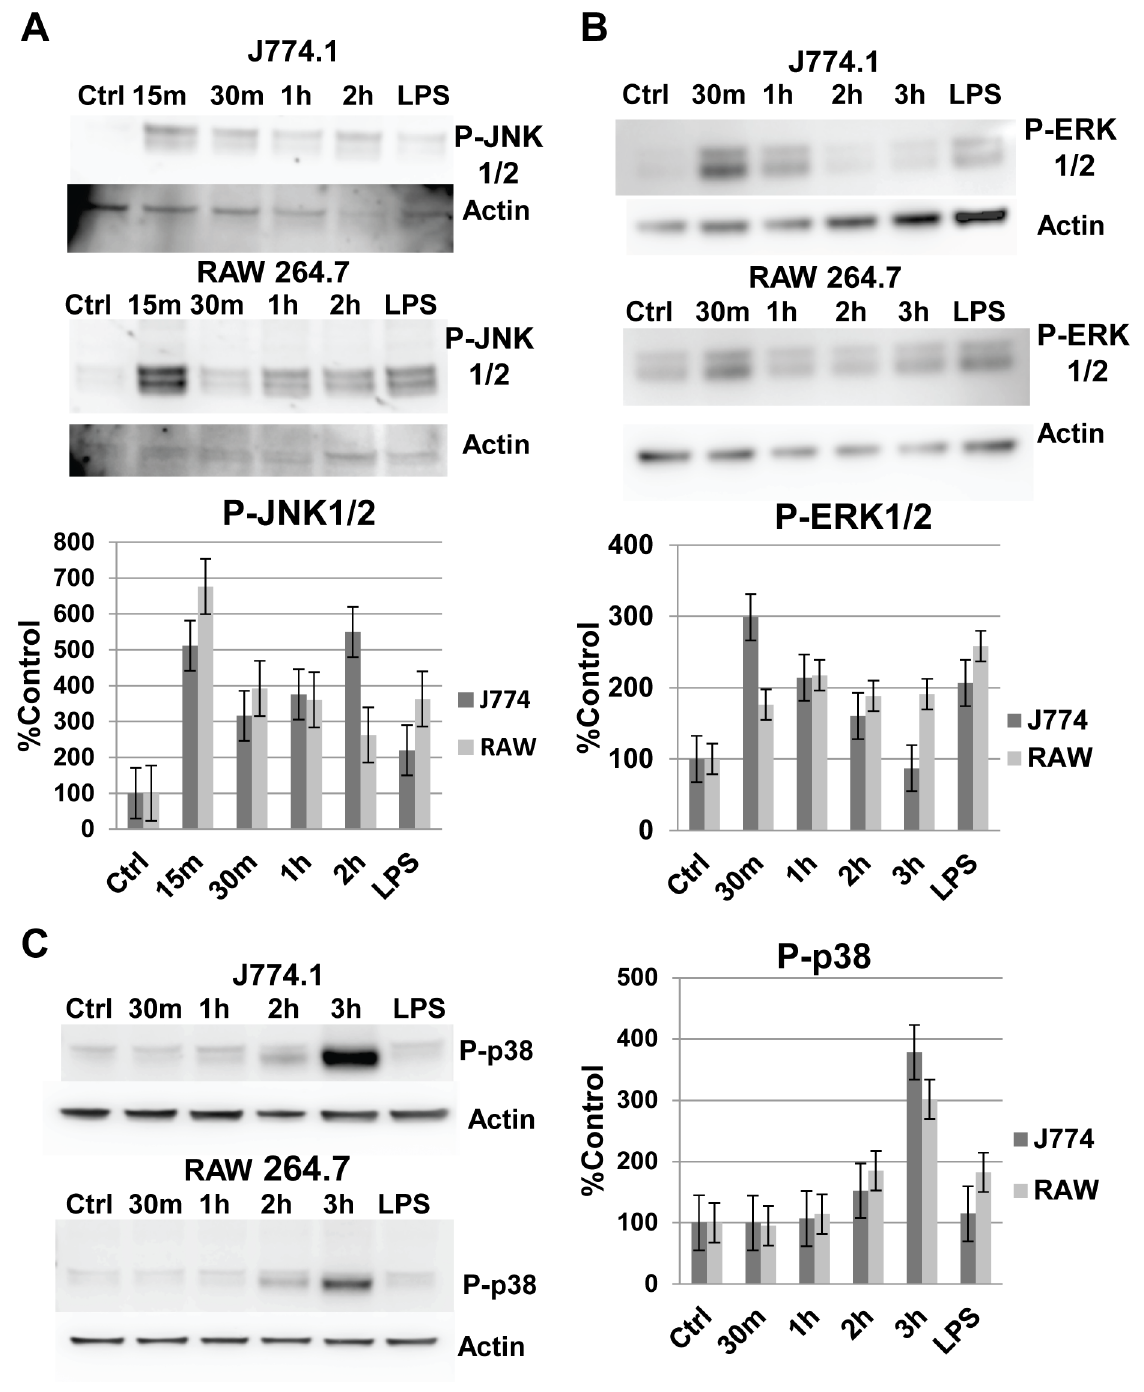
Figure 4. MAPKs are rapidly phosphorylated following FLUA infection. A. J774.A1 and RAW 264.7 cells rapidly phosphorylate JNK 1/2 in response to X-31 exposure. In both cell lines maximal response was reached by 15 minutes post virus exposure. Control and LPS treated (1 m g/ml for 15 minutes) cells were mock infected. Representative Western blots and densitometry graphs from the Western blots (data are mean 6 SEM, n=5 independent experiments). B. J774.A1 and RAW 264.7 cells rapidly phosphorylate ERK 1/2 in response to X-31 exposure. In J774.A1 cells maximal response was reached by 30 minutes. RAW 264.7 cells had a lower maximal expression that was reached by 1 h. Control and LPS treated (1 m g/ml for 15 minutes) cells were mock infected. Representative Western blots and densitometry graphs from the Western blots (data are mean 6 SEM, n=4 independent experiments). C. J774.A1 and RAW 264.7 cells phosphorylate p38 in response to X-31 exposure. In both cell lines maximal response was reached by 3 h, a noticeable delay compared to the JNK1/2 and ERK1/2 activations. The antibody used recognizes a , b and c p38 isoforms. Control and LPS treated (1 m g/ml for 15 minutes) cells were mock infected. Representative western blots and densitometry graphs from the western blots (data are mean 6 SEM, n=5 independent experiments).